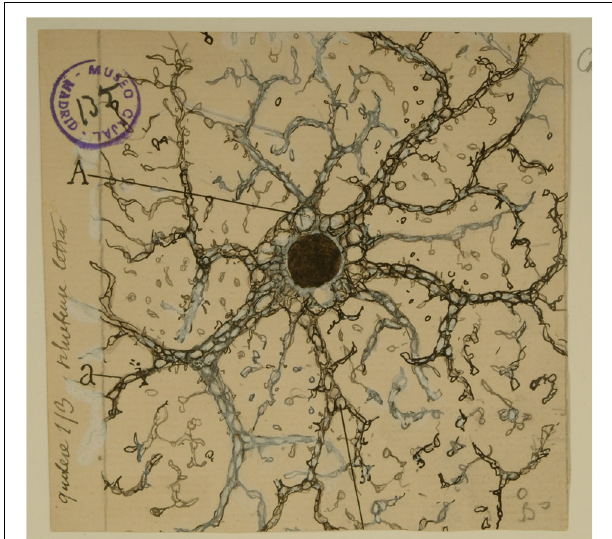
FIGURE 1 | Cajal’s drawing showing a “neuroglia” of the pyramidal layer and stratum radiatum of the Ammon horn from adult man autopsied 3h after death. (A) Indicates the large vacuoles of the soma; (a and b), the gaps of the expansions intended for the gliosomas. Reproduced from an original drawing, with permission of the Instituto